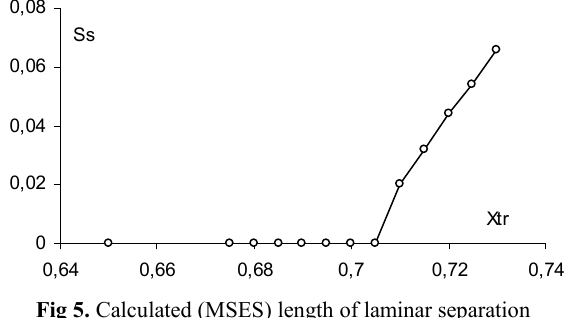
Fig 7. Calculated (MSES) shape parameter H K at the transition versus forced transition location on the upper side of airfoil 1 at a = 0 Fig 8 shows the drag coefficient versus shape parameter H of the boundary layer at the transition on K the upper side of airfoil 1 versus transition location at a = 0. Drag coefficient is minimal when the shape parameter is H = 3.65. Fig 9 and 10 shows the same K function for -1.5° and 2° angles of attack. The minimum drag is also approximately at H = 3.65. The curves in the K minimum region are flat. If the shape parameter does not exceed the value H = 3.8, the drag is near the minimum. K